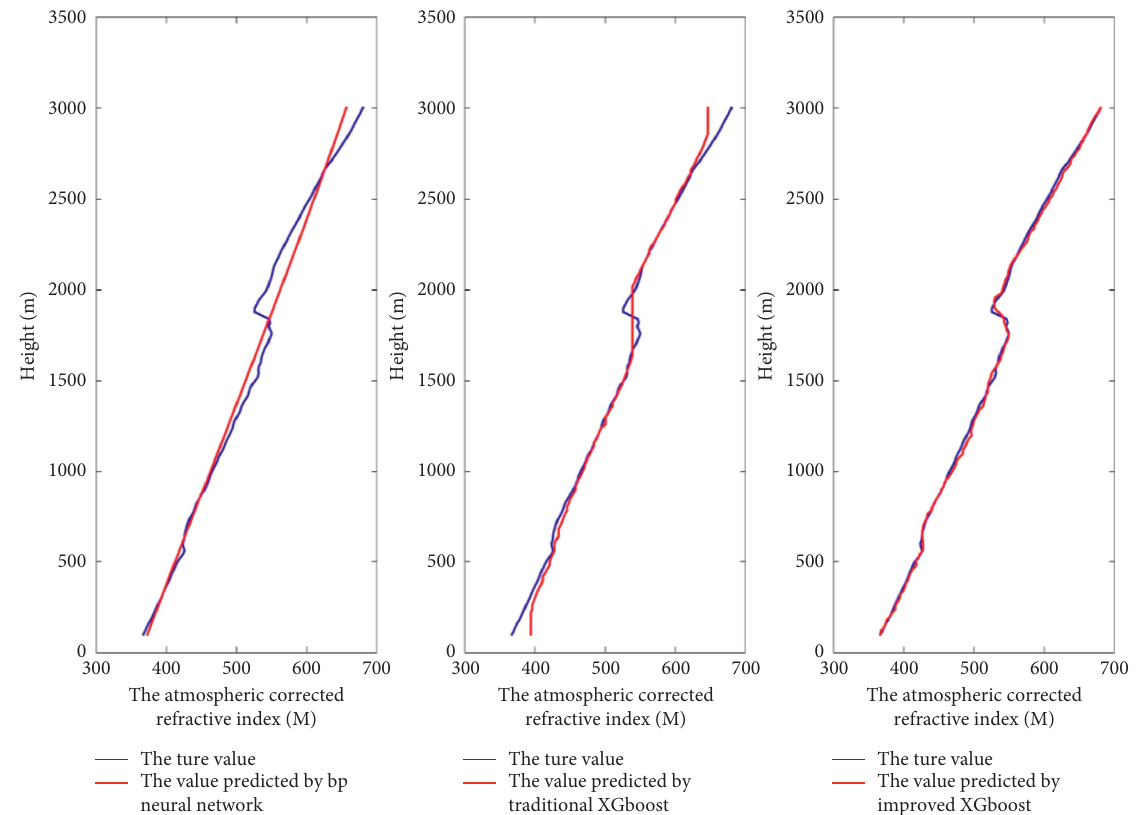
Figure 6: The results for a randomly selected vertical